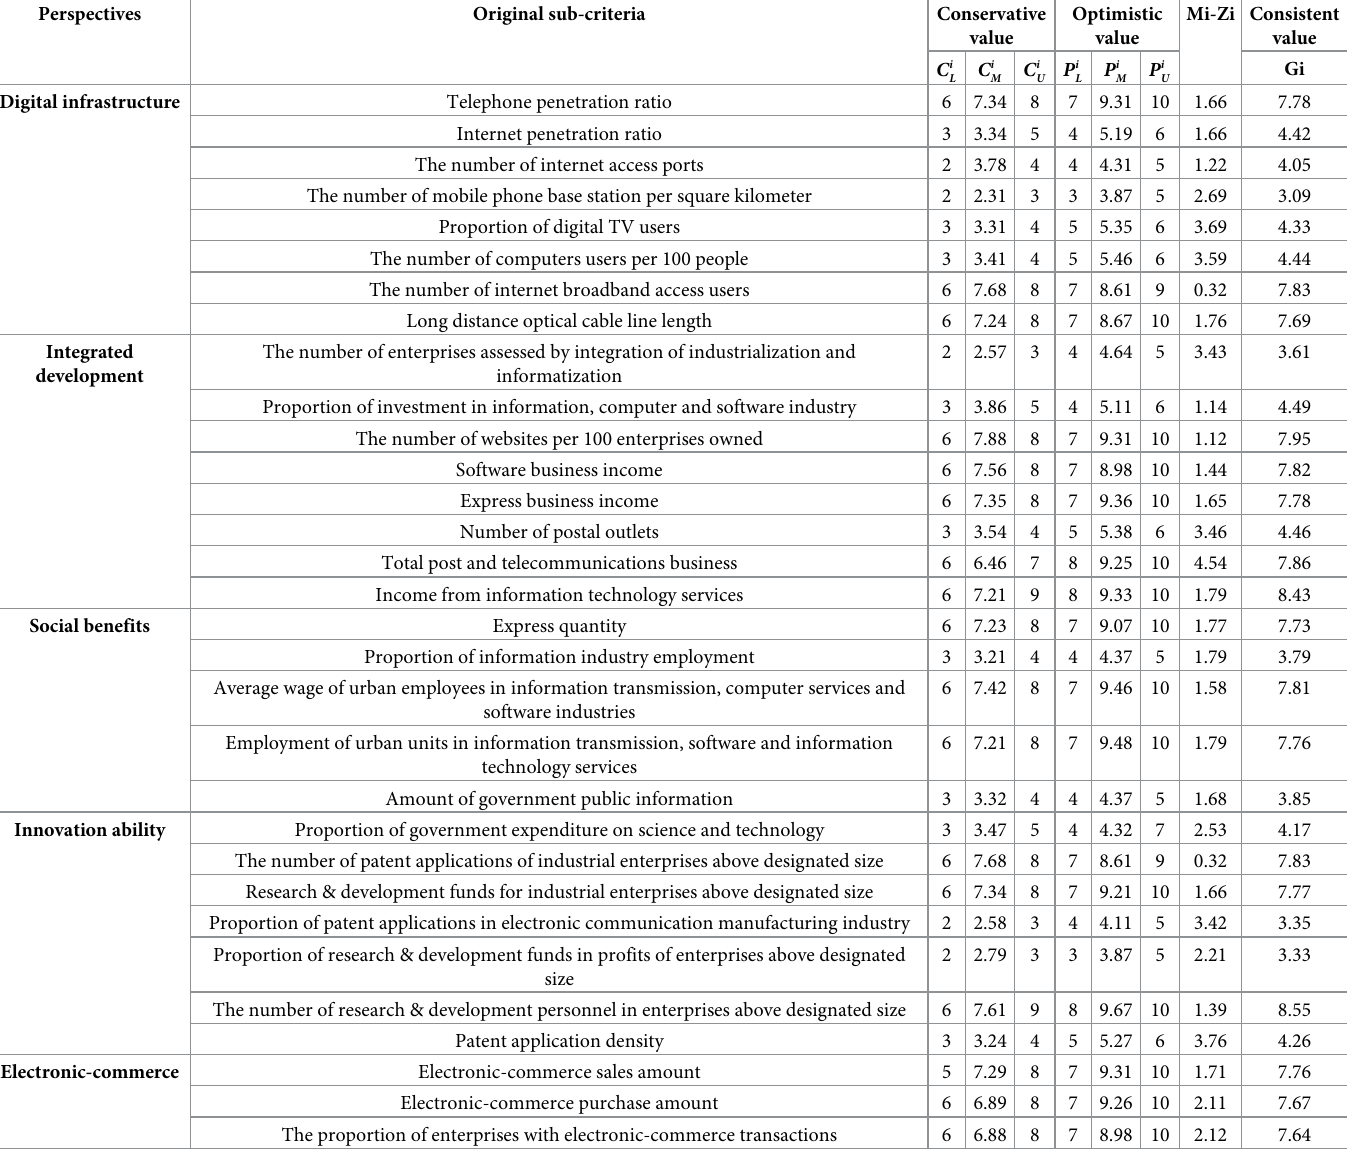
Table 2. Results of Fuzzy-Delphi method in screening critical sub-criteria.